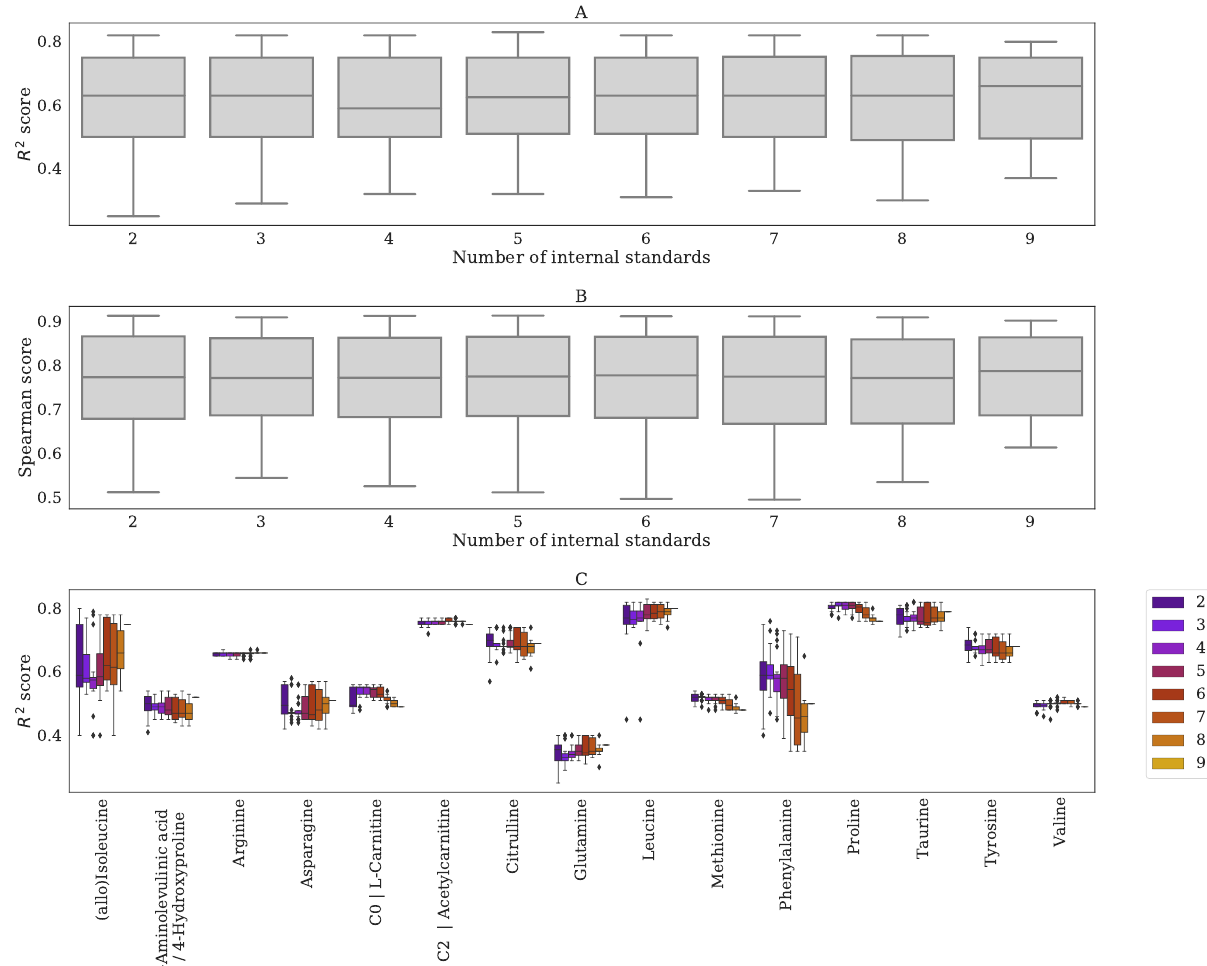
Figure A4. Performance of normalization based on a comparison with quantitative measurements for increasing the number of internal standards with BC-Metchalizer . ( A ) R 2 score ( B ) Spearman score ( C ) R 2 score per metabolite and number of internal standards. The legend indicates how many internal standards were used for